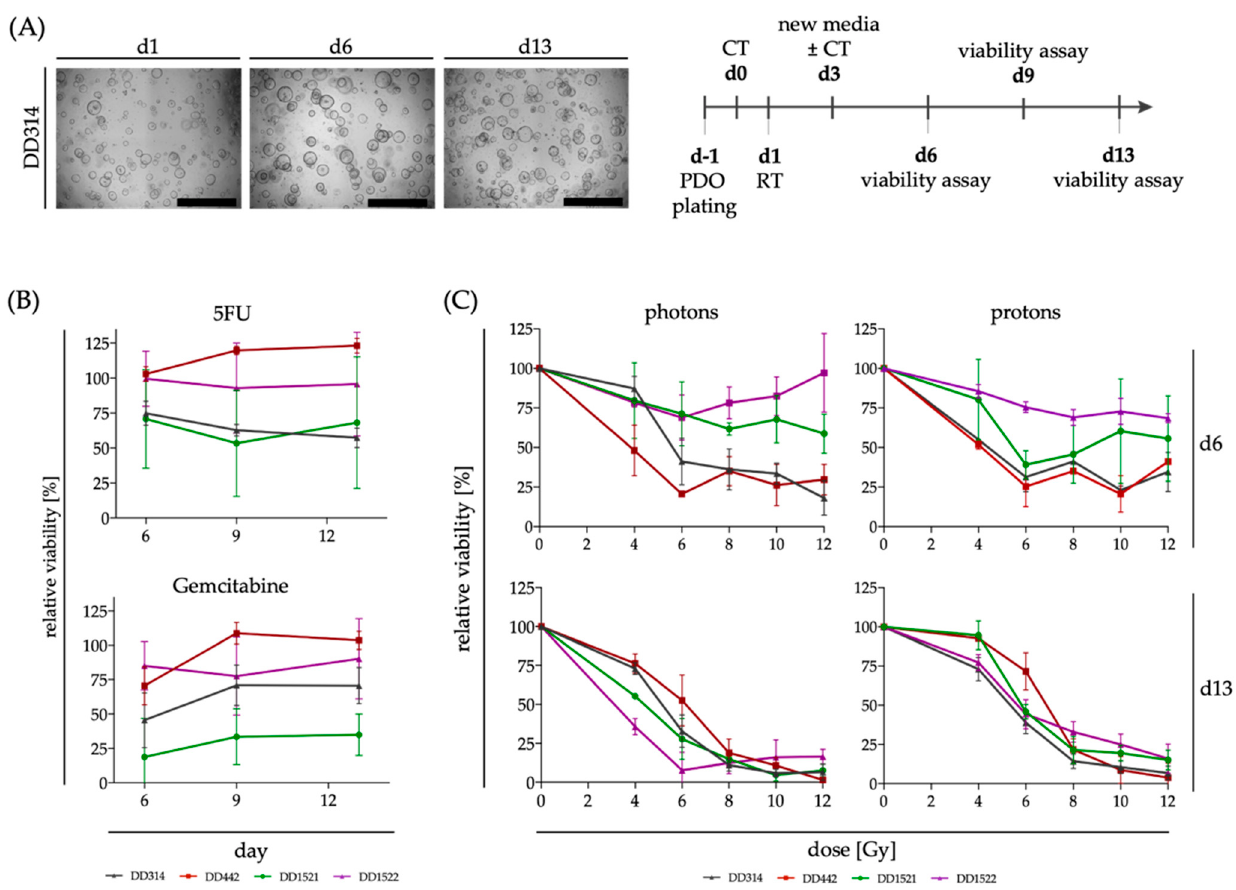
Figure 3. Response of PDOs to single treatments with CT and RT ( A ) PDOs were seeded one day before CT treatment (=d0) and were irradiated after one day. Media was changed after three days and after every viability assay on the days 6, 9 and 13 post CT treatment. Brightfield images show representative untreated PDOs at the different timepoints (scale bar: 500 µ m). ( B ) Relative viability ± SD of PDOs after treatment with CT (5FU, 5 µ M; gemcitabine 10 nM) at different timepoints after treatment ( n = 4 for DD1521 and n = 5 for the other lines for 5FU; n = 6 for DD1522 and n = 5 for the other lines for gemcitabine, respectively). ( C ) Dose–response curves of PDOs based on viability measurement with PrestoBlue assay on day 6 and 13 after irradiation with either photons or protons show the dose dependent normalized viability ± SD ( n = 2 for DD1521 for photons, all other conditions n = 3). Table 2. Therapeutic effects after treatment with RT and CT on day 13.